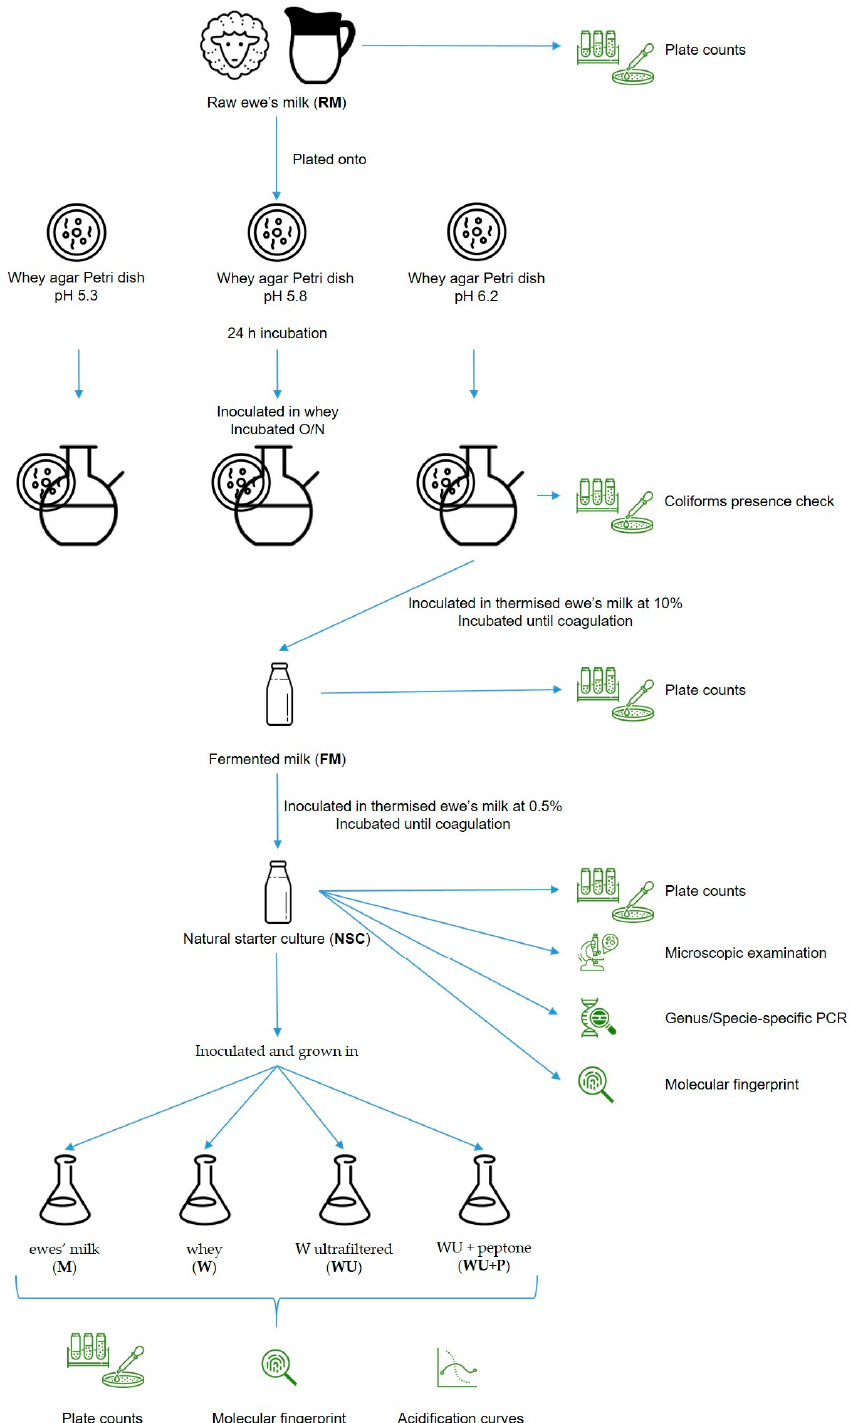
Figure 1. Experimental plan regarding the production of a natural starter culture (NSC). The raw ewe milk (RM) was plated onto whey agar dishes, each at a different pH, and, after incubation, transferred into a whey solution and incubated again for 24 h. Then, the whey inoculated with the plate at pH 6.2 was used to inoculate sterile ewes’ milk (at 10%) to obtain, after inoculation, fermented milk (FM). The FM microbiota was grown in sterile ewe milk to obtain NSC, which was characterised at the phenotypic and molecular scale. The development of NSC microbiota in milk (M), whey (W), W ultrafiltered (WU), and WU supplemented with peptone (WU + P) was also investigated and compared by plate count, molecular fingerprint, and kinetics of acidi fi cation.